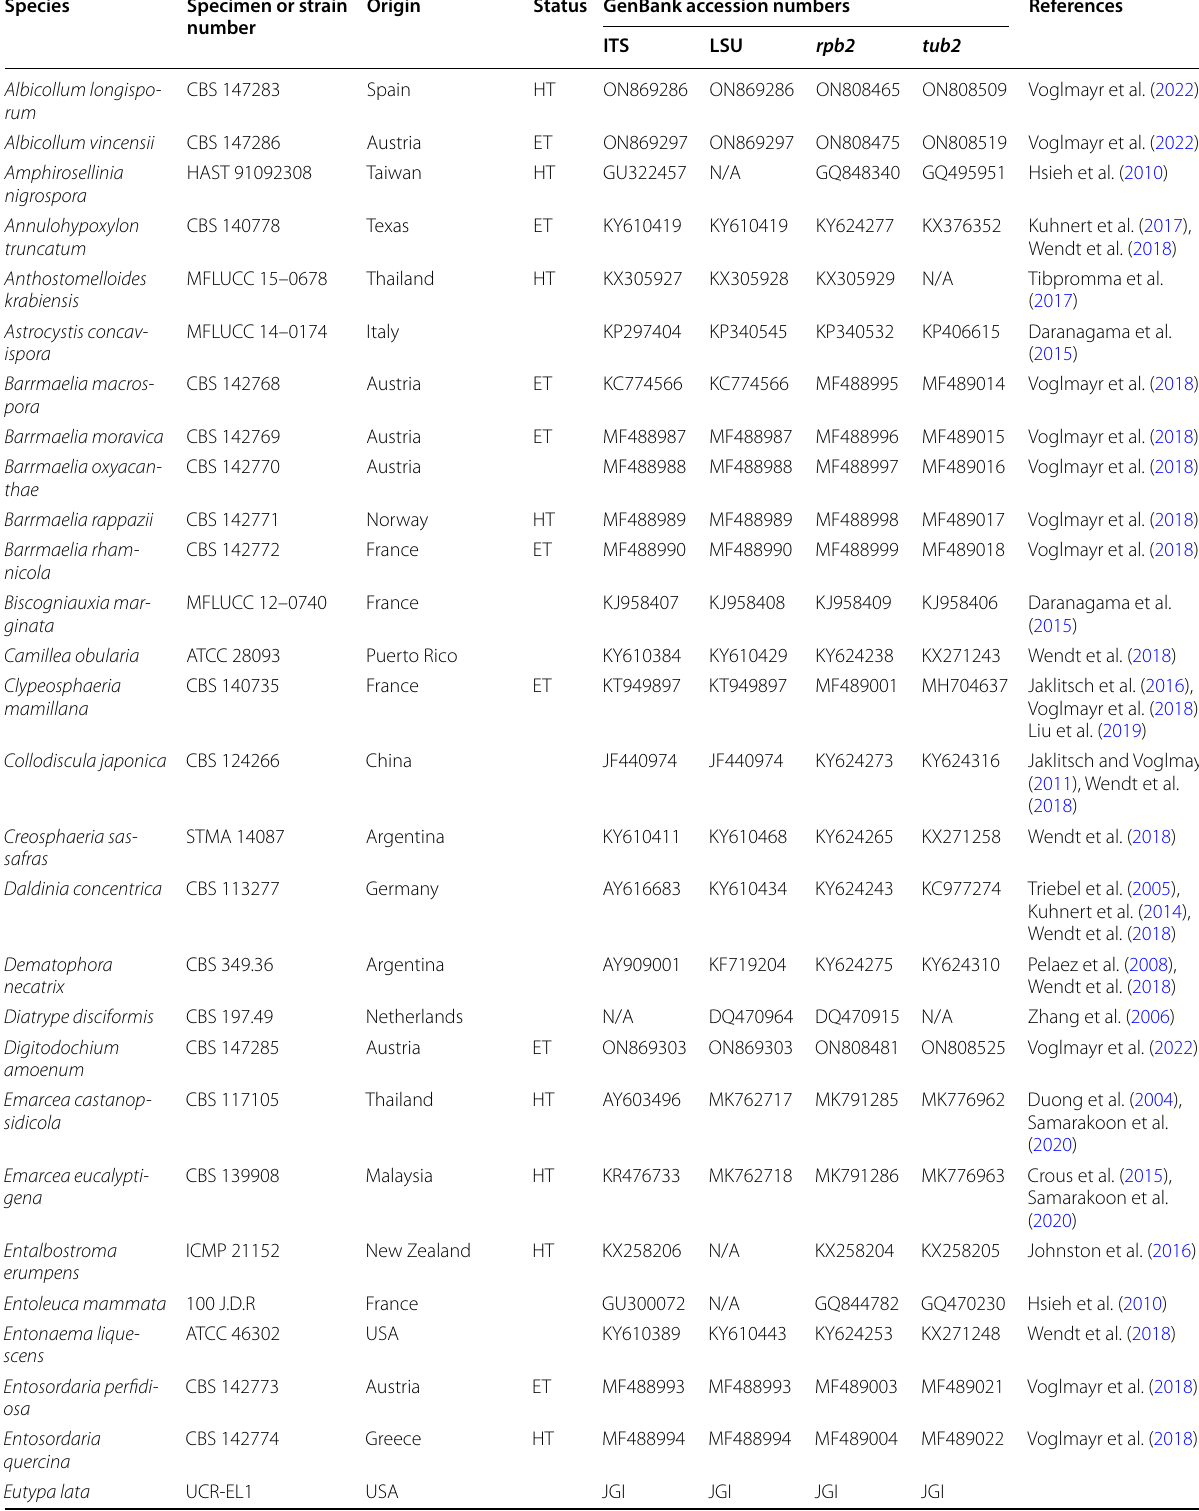
Table 1 Feature table listing all sequences used for molecular phylogenetic inference. GenBank sequence accession numbers, type status of taxa, country of origin and specimen/strain numbers are given in the respective